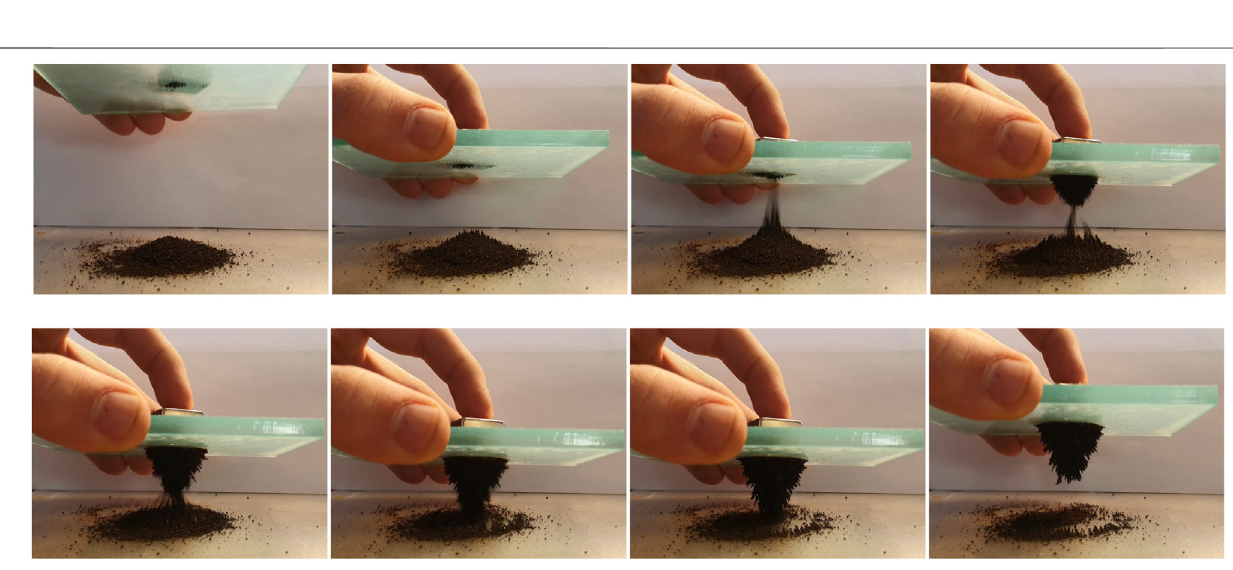
FIGURE 4 | Manipulation of the magnetic coffee ground using a permanent